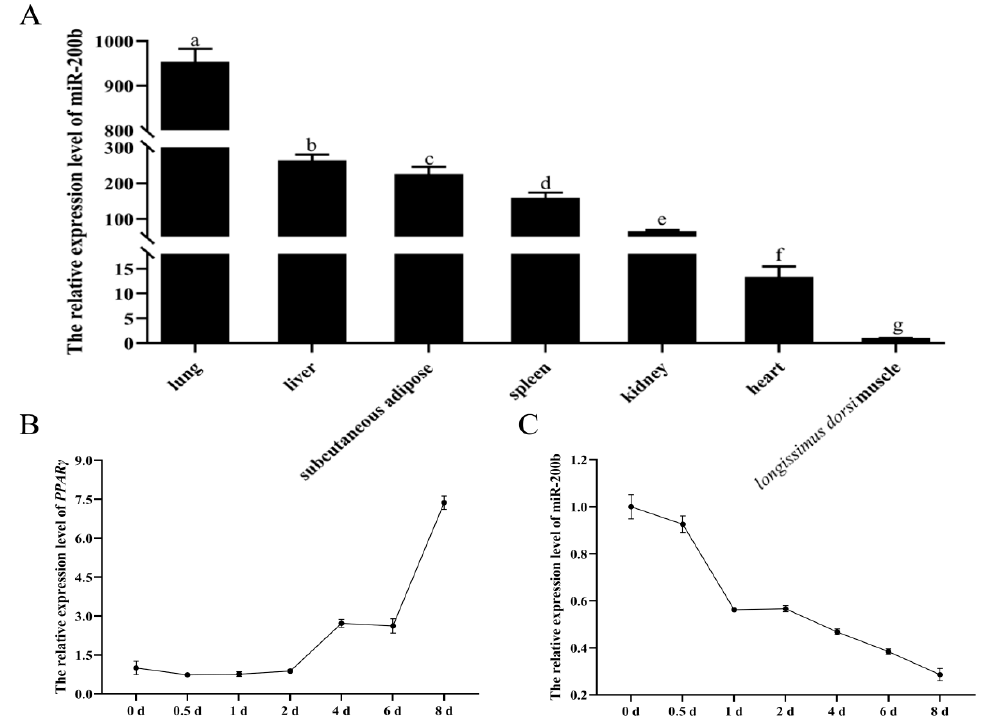
Figure 1. The expression profiles of miR-200b and PPAR γ . ( A ) The expression level of miR-200b in the ovine seven different tissues. The expression levels of PPAR γ ( B ) and miR-200b ( C ) during ovine preadipocyte differentiation. The values are shown as mean ± SD ( n = 4). Values with different lowercase letters are different at p <